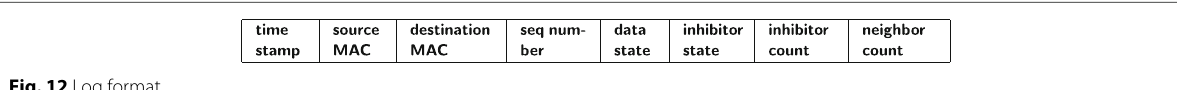
frame gets discarded. According to the specification of counter-based scheme in [4], our approach can also be characterized broadly as counter-based